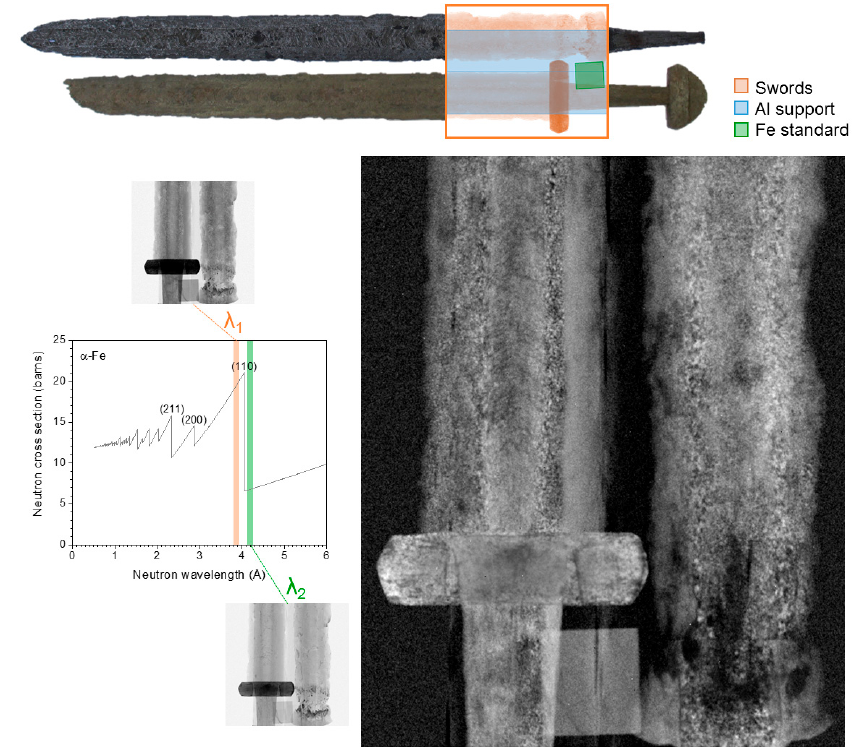
Figure 11. Transmission image of a section of two ‘pattern-welded’ Viking swords (see diagram above for the position along the blade). Transmission images have been measured before ( λ 1 ) and after ( λ 2 ) the 110 ferrite Bragg edge, and by subtracting the two is was possible to obtain a transmission image enhancing the signal from ferrite [15] (original pictures).